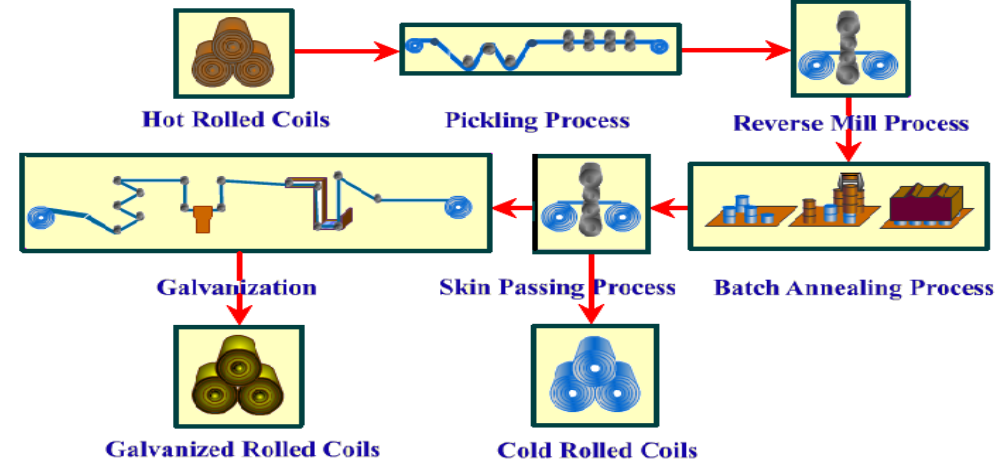
Figure 3. “A flow chart of the rolling and the galvanization for coils”.